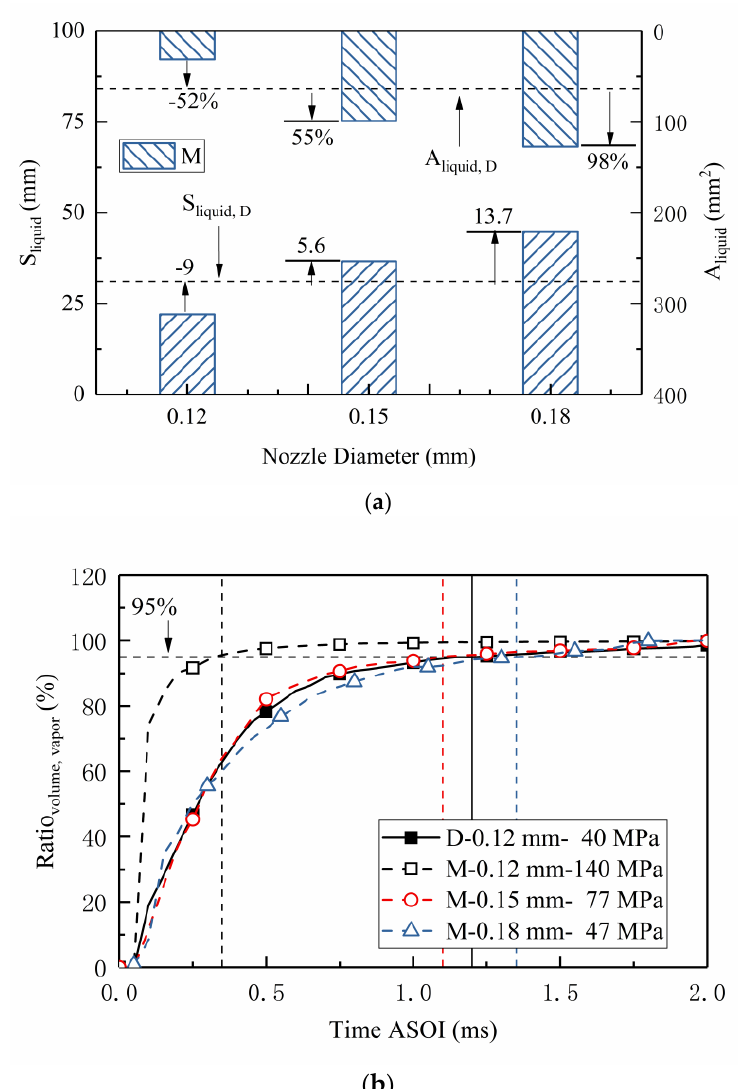
Figure 15. Comparison results of the spray evaporating characteristics under different strategies. ( a ) Results of the liquid phase spray. ( b ) Volume fraction of the vapor phase.